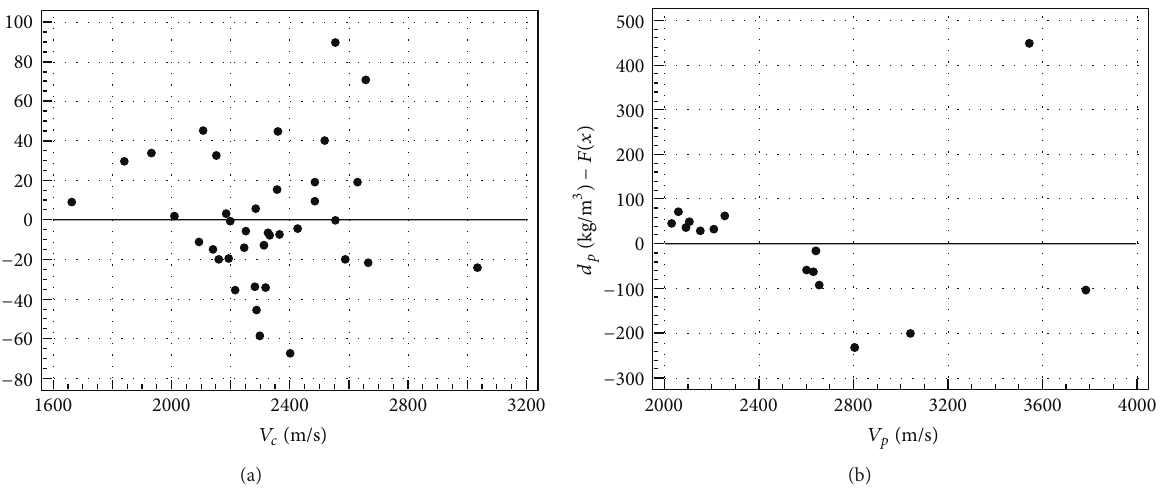
Figure 7: Residuals plot of density in cubes (a) and prisms (b).